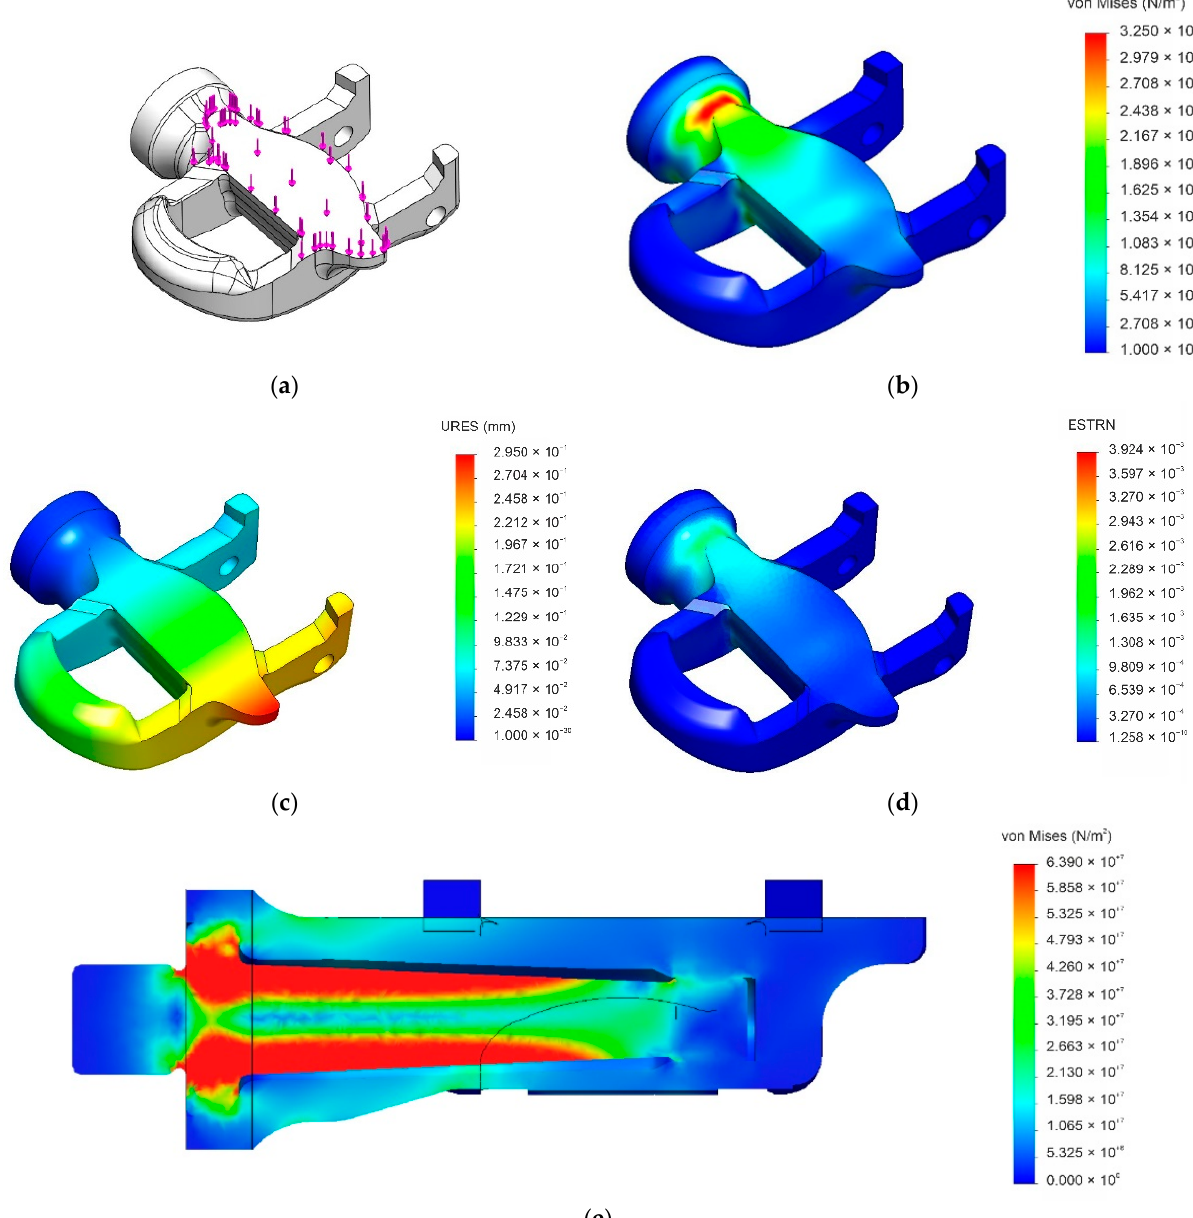
Figure 4. Graphic output summaries of the finite-element analysis of a PA11 + 60% SGW pedal body during pedalling under a force of 1300 N. ( a ) Loaded surface; ( b ) Von Mises stress; ( c ) net displacement; ( d ) percent strain; ( e ) effort transmission to axle.